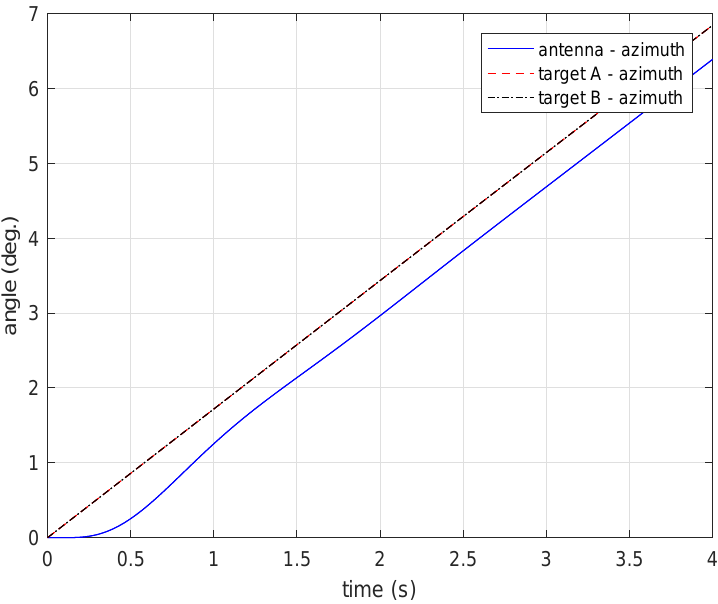
Figure 17. The azimuth response against a single target, run separately for targets A and B, in order to validate the system